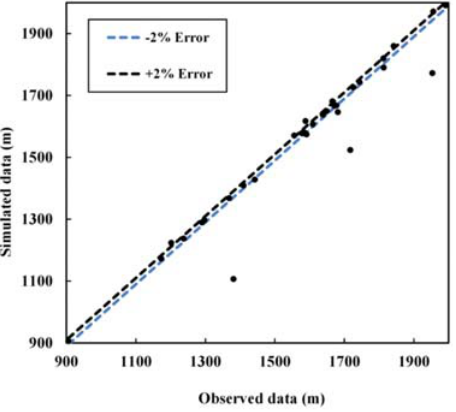
Figure 8. Fit between the observed data and the simulated data.